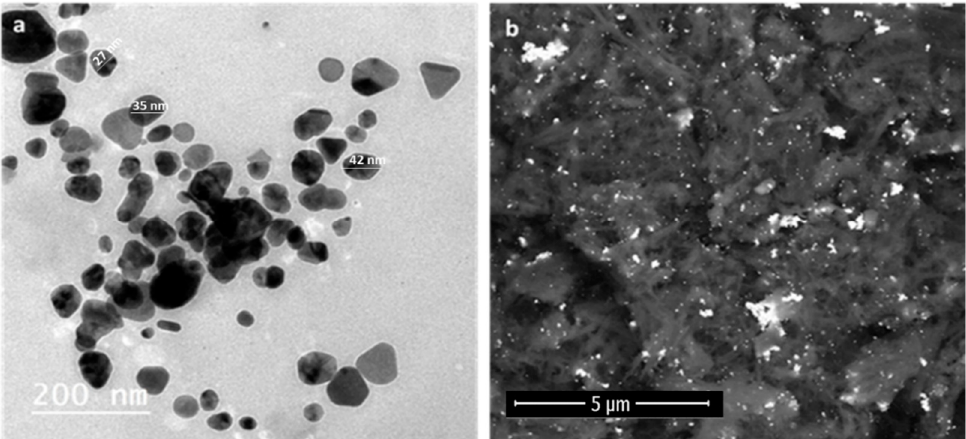
Figure 3. ( a ) TEM micrographs for poly ‐ dispersed shapes and triangle ‐ shaped CE ‐ AgNPs; ( b ) FE ‐ SEM micrographs for prepared CE ‐ AgNPs.